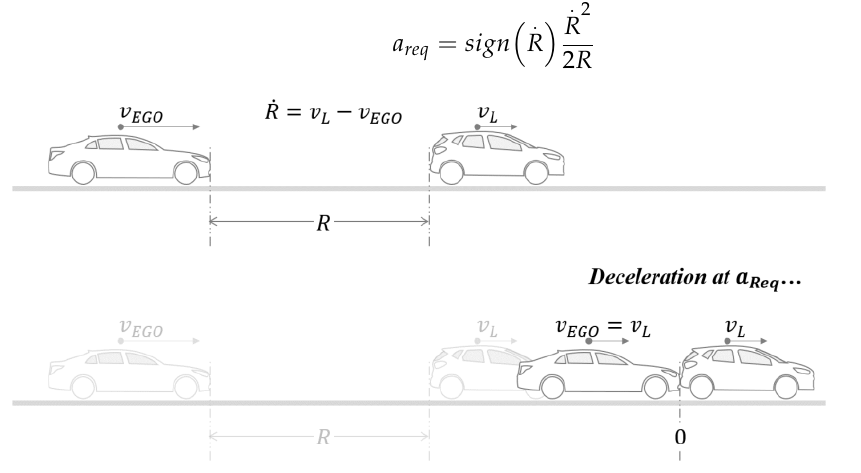
Figure 6. Scheme of required deceleration.